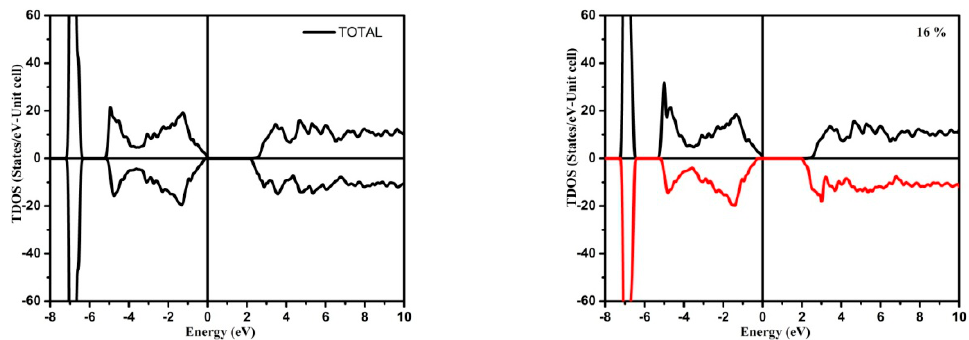
Figure 3. Total Density Up and Down of states for Mn x Zn 1 − x Te crystals (x = 8% and 16%).